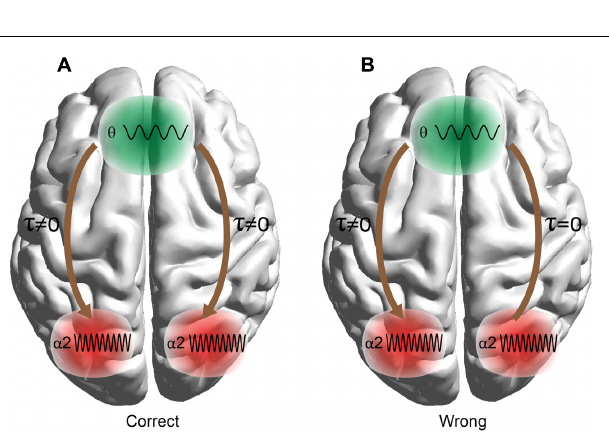
FIGURE 7 | Time-lag effects between F and PO sites in (A) correct and (B) wrong trials. The analysis detected time-lag effects for three out of four combinations (right and left PO × correct and wrong trials) with the exception of bilateral F and right Parieto-Occipital sites in wrong trials.